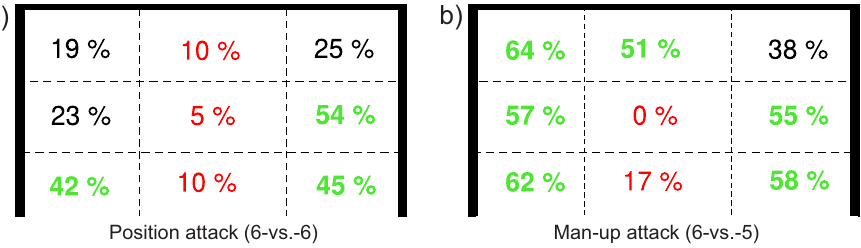
Figure 5. Overall hit rates of all players participating in the water polo World Cup Final 2018 in the different target zones of the water polo goal (separated for ( a ) position attack and ( b ) man-up attack situation of the team).